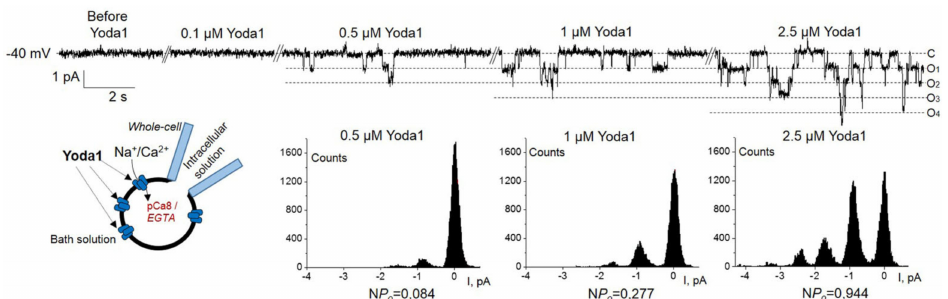
Figure 3. The detection of Piezo1 activity in response to submicromolar Yoda1 concentration. Rep- resentative whole-cell recording demonstrates single Piezo1 currents at various extracellular bath Yoda1 concentrations starting from 0.5 µ M. Corresponding amplitude histograms and N P o values (calculated on presented intervals) are shown below the